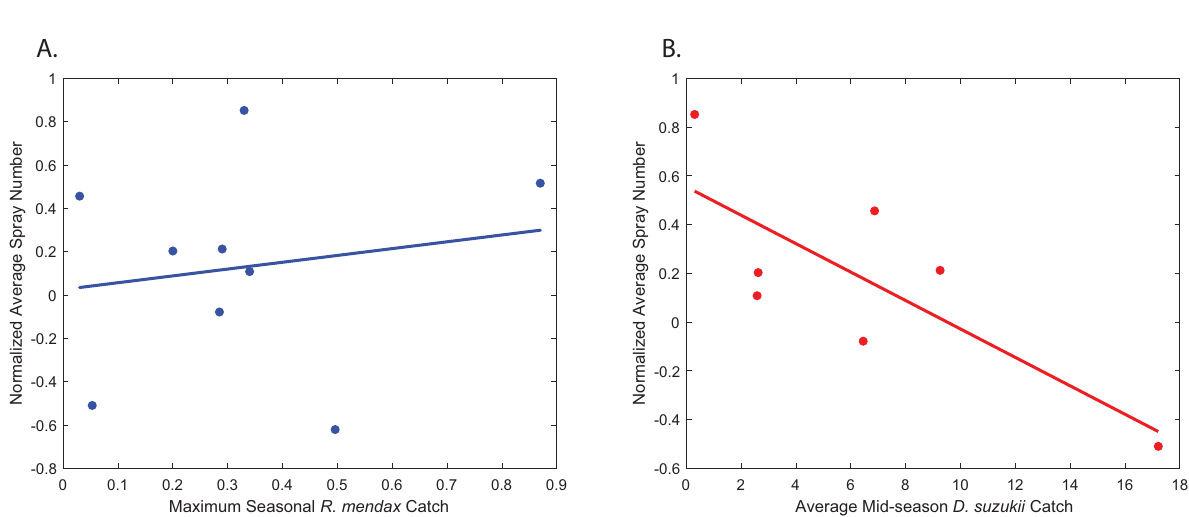
Fig 3. Normalized average annual post-bloom insecticide sprays compared to A. annual peak trap captures of Rhagoletis mendax (blue, with linear trend) and B. average midseason trap captures of Drosophila suzukii (red, with linear trend). Drosophila suzukii captures are significantly correlated with spray numbers at r = − 0.78 with P =